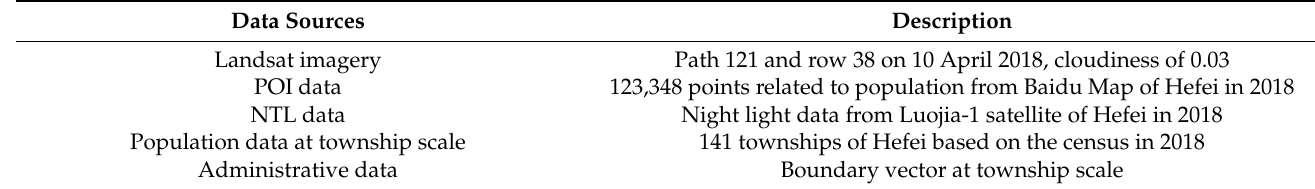
Table 1. Data sets used in this study.